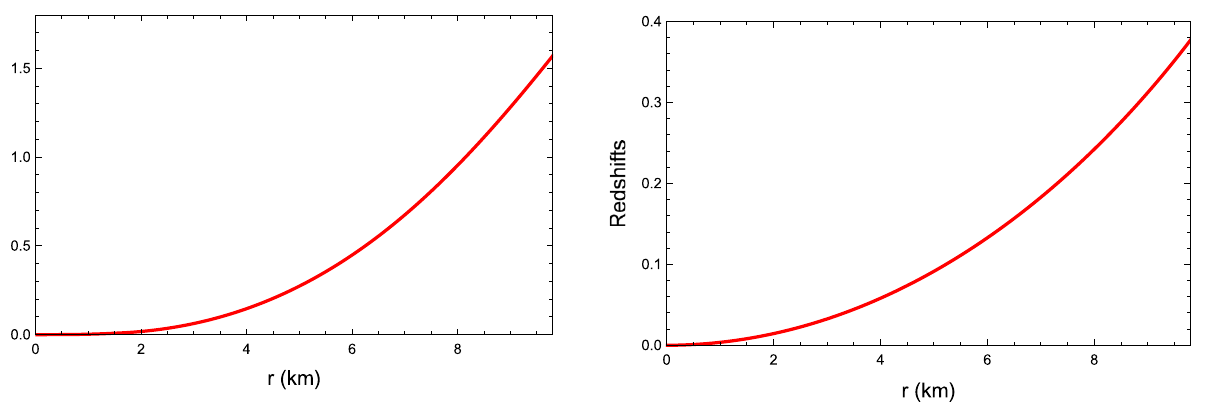
Fig. 13 Variation of gravitational redshift with radial coordinate r is increasing in